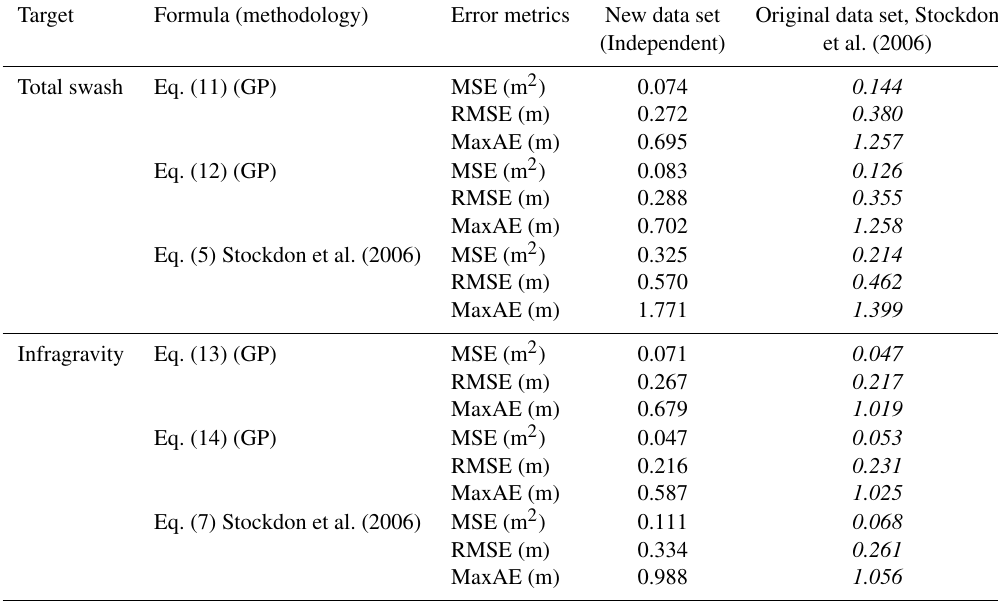
Table 2. Results of error metrics for both total and infragravity swash, calculated for the GP predictors and Stockdon et al. (2006) on both original and new data sets. The results calculated with the original data set (in italics) do not represent a test of any predictor, only a consistency check – all original data were shown to the GP algorithm and used by Stockdon et al.